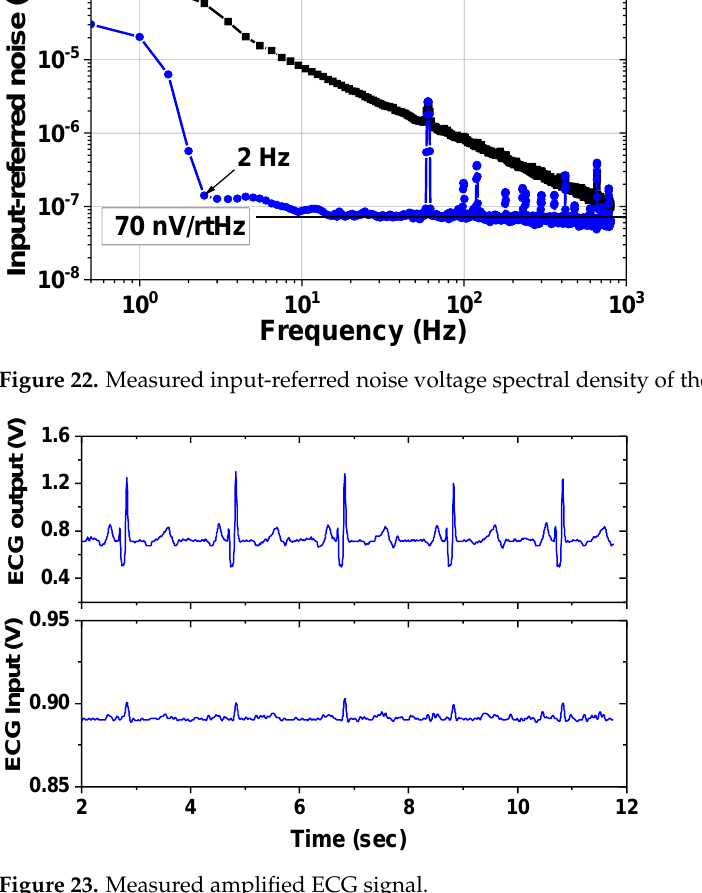
Figure 23. Measured amplified ECG signal.